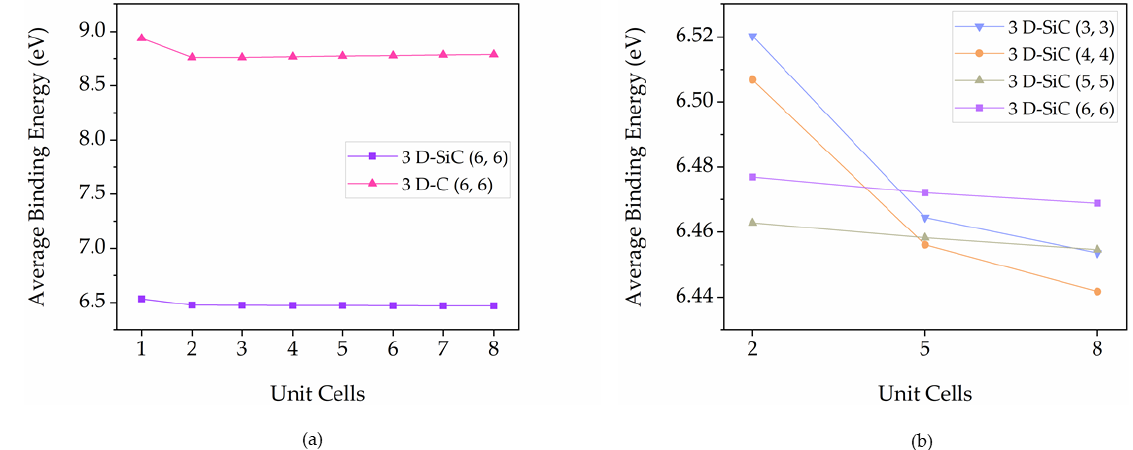
Figure 7. The average binding energies of ( a ) 3D pillared C and SiC nanostructures as a function of pillar length and ( b ) 3D pillared SiC nanostructures as a function of pillar diameter.